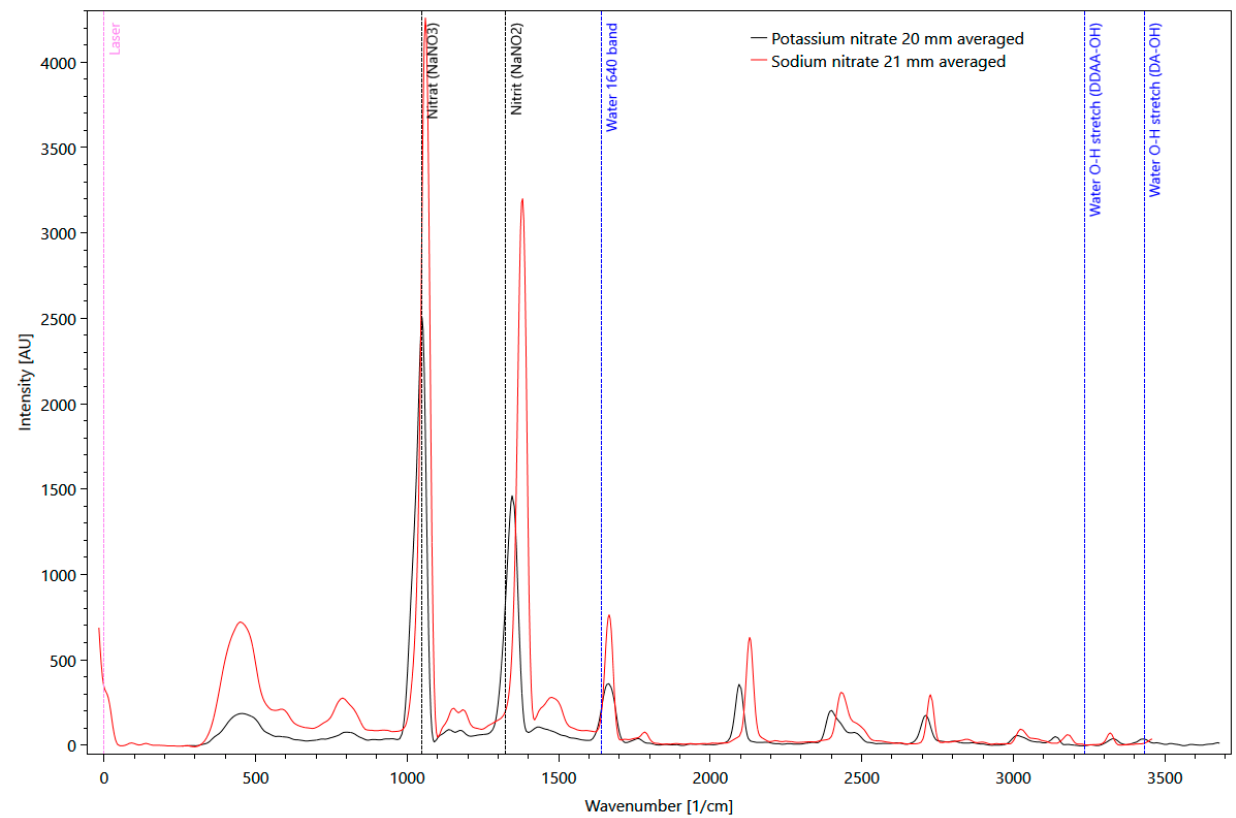
Figure 6. Comparison of pure potassium (black line) and sodium nitrate (red line) Raman spectra, measured as solid matter in a fused silica cuvette, with background information about molecular vibrations of H 2 O (blue dotted lines).